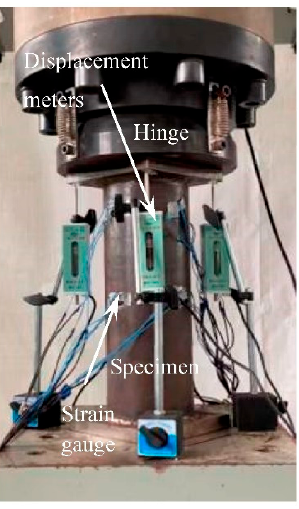
Figure 5. Test Figure 5. Test equipment.